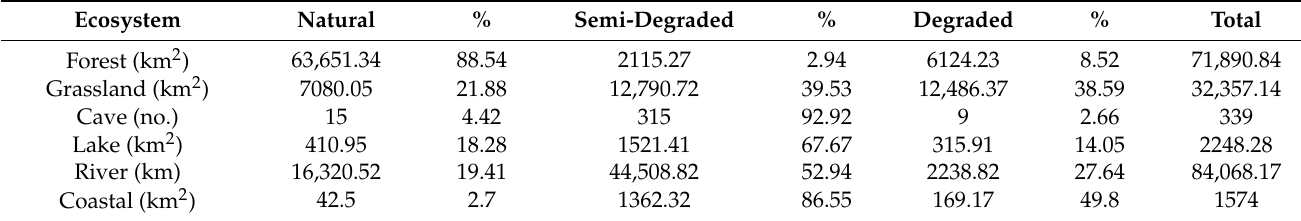
Table 2. Summary of ecosystem assessment